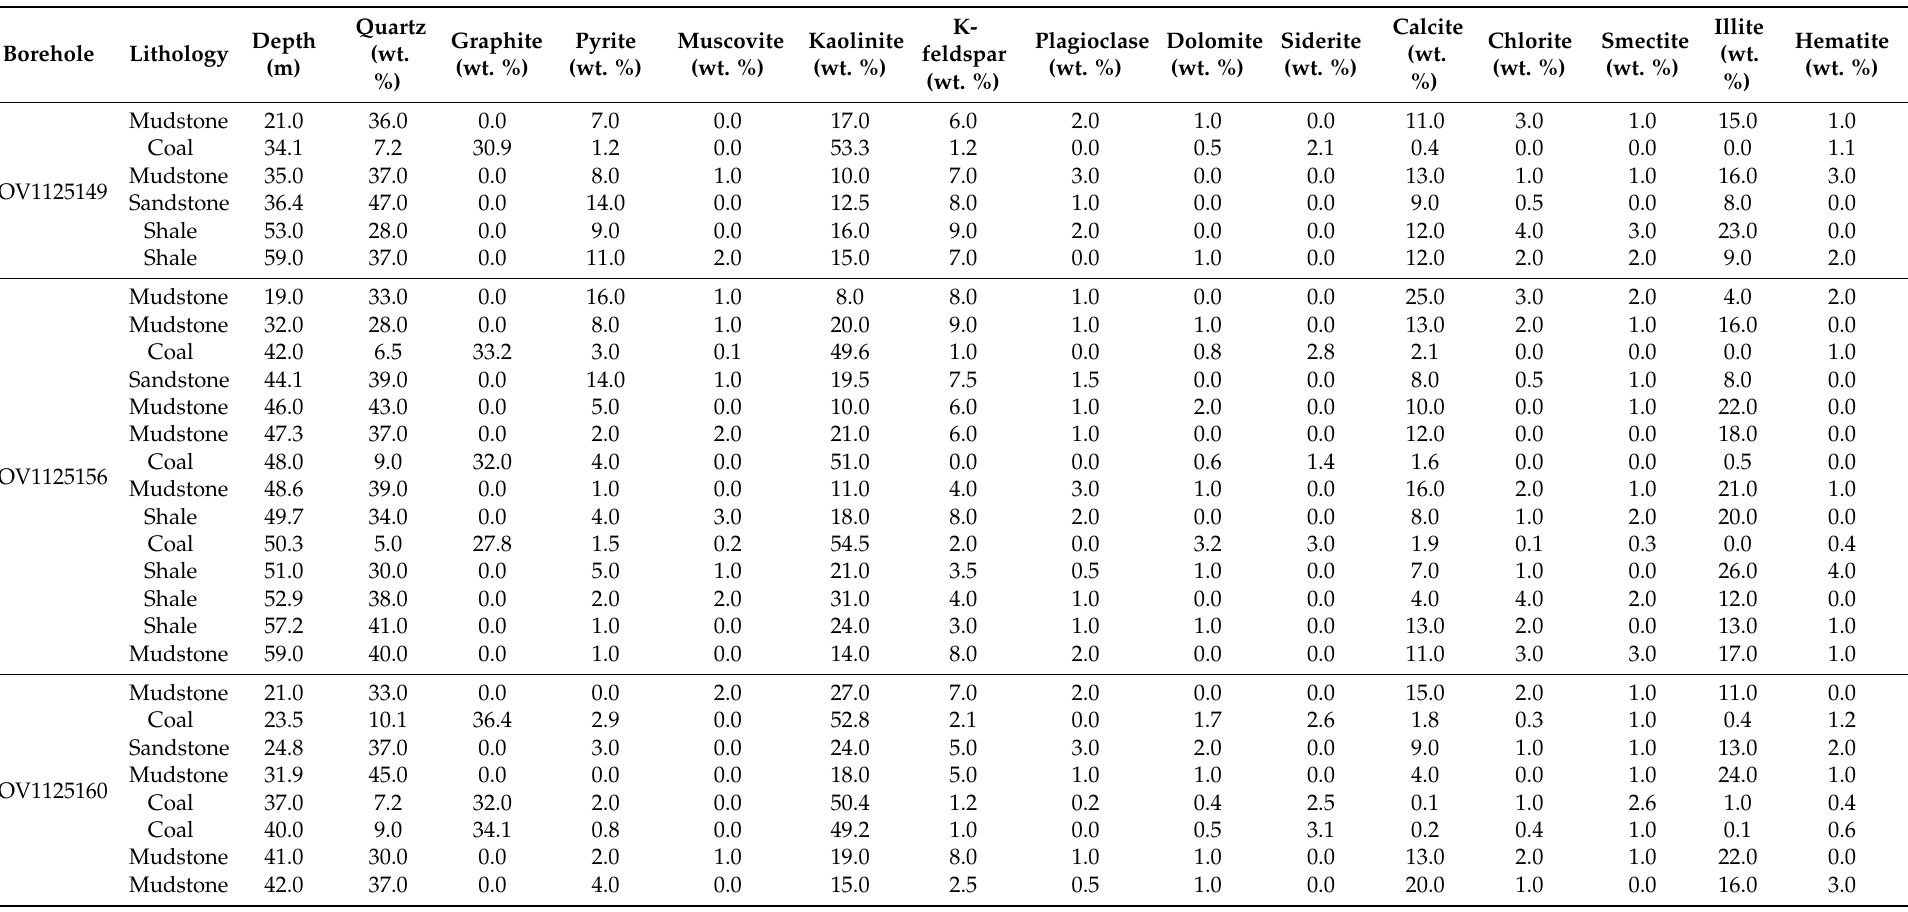
Table 1. Results of X-ray Diffraction